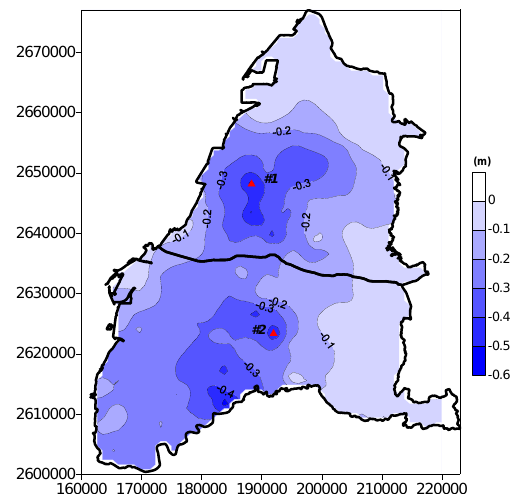
Figure 5. Subsidence distribution in Jhuoshuei River Alluvial Fan in 2039 obtained using NPM and GSM. Triangle symbols numbered #1 and #2 are locations of demonstration points used for fusion re- sults in Fig. 6 (From Wang, 2015).